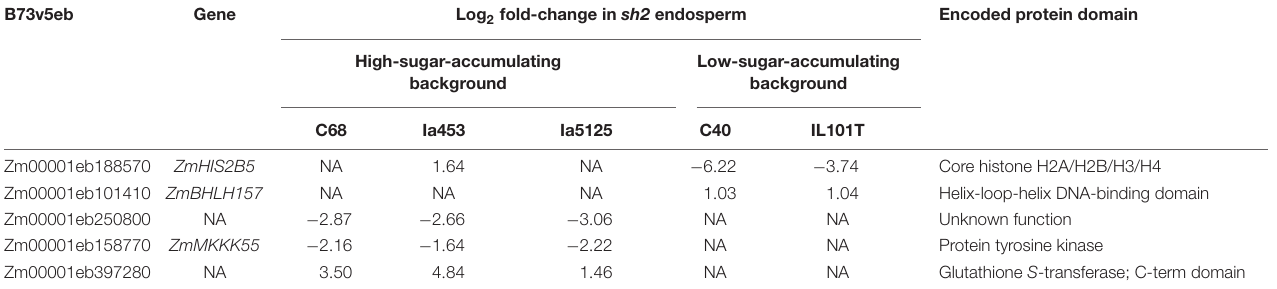
TABLE 2 | Differential expression of putative modifiers.